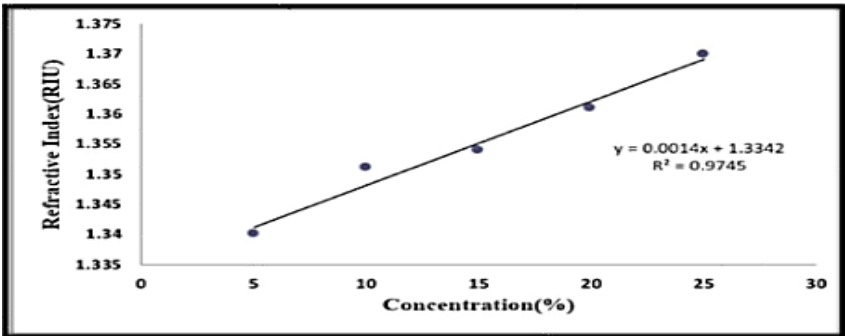
Figure 5: Refractive index of sucrose solution in water as a function of solution concentration.